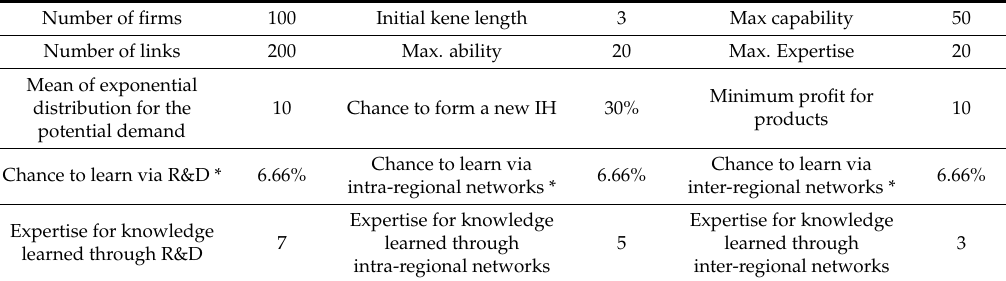
Table 1. Standard setting of parameters.